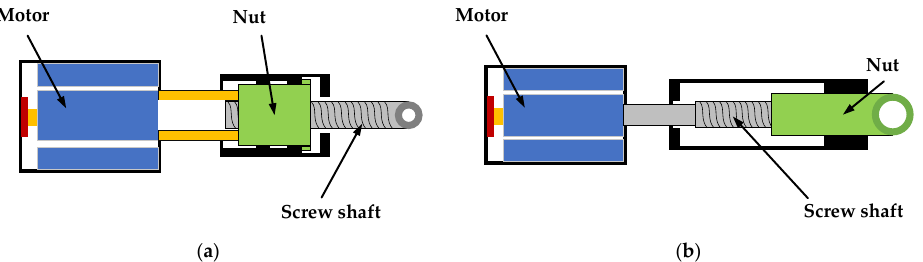
Figure 1. Basic structures of EMA systems [15]. ( a ) EMA using the screw shaft as the driving com- ponent; ( b ) EMA using the nut as the driving component. Some scholars have studied the dynamic modeling method of ball-screw pairs. Liu et al. [16] established a 14-DOF dynamic model of a ball-screw feed system including a ball-screw pair and a linear guide rail. The radial and axial vibration of the ball-screw pair was studied, and the stiffness and nonlinear restoring force of each component were cal- culated. Xu et al. [17] established a lumped parameter model of a ball-screw feed system and studied the relationship between the displacement of the ball nut and the nonlinear restoring force under cycling load. Liu and Ou [18] established an axial contact stiffness model of a ball-screw feed system and proposed a calculation method for the dynamic axial contact stiffness of the ball-screw pair. Gu and Zhang [19] established a dynamic model of a ball-screw feed system considering the time-varying stiffness and studied the influence of the position of the worktable on the control performance and positioning ac- curacy. Guo et al. [20] proposed a new dynamic modeling method for a ball-screw feed system. A model with high positioning accuracy of the ball-screw feed system was ob- tained by combining the classical dynamic theory with an artificial neural network. Ber- tolino et al. [21] built a high-fidelity model of a ball-screw pair, wherein the balls inside the nut were modelled as spring-damping systems, and the contact force of each ball was analyzed. In their subsequent research, a multibody dynamic model of a double-nut ball- screw pair was established. In this model, the inertia of each subcomponent of the ball- screw pair was considered, and the influence of friction and lubrication was also taken into account [22]. However, the studies mentioned above have examined the ball-screw feed system as the research subject. The main purpose of their models was to improve the control perfor- mance and control accuracy of the ball-screw feed system. Few studies have implemented detailed dynamic modeling for the possible faults of the ball-screw pair in an EMA and investigated the possible impacts of faults on the radial or axial vibration characteristics of the ball-screw pair. Therefore, it is necessary to establish a systematic model of a ball- screw pair and comprehensively study the impact of faults on the radial and axial vibra- tion of the ball-screw pair. Furthermore, it is necessary to determine in which direction the fault characteristics are most obvious, analyze the specific performance of faults oc- curring in the dynamic responses of the system and extract fault features or establish health indicators (HI) of the ball-screw pair so as to realize fault identification and fault diagnosis in EMA mechanical transmissions. This paper is dedicated to establishing a comprehensive dynamic model containing typical mechanical components of EMAs (such as ball-screw pairs and bearings) and stud- ying the coupling effect between the radial and axial vibration of ball-screw pairs in EMAs. After implantation of a spalling fault on the raceway of the nut, the fault charac- teristics that would possibly occur in the radial and axial responses of EMA systems are studied, the fault features are extracted and a specific calculation method for fault charac- teristics is proposed, laying a foundation for subsequent research on EMA fault diagnosis and fault prognosis. The remainder of this paper is structured as follows. In Section 2, an